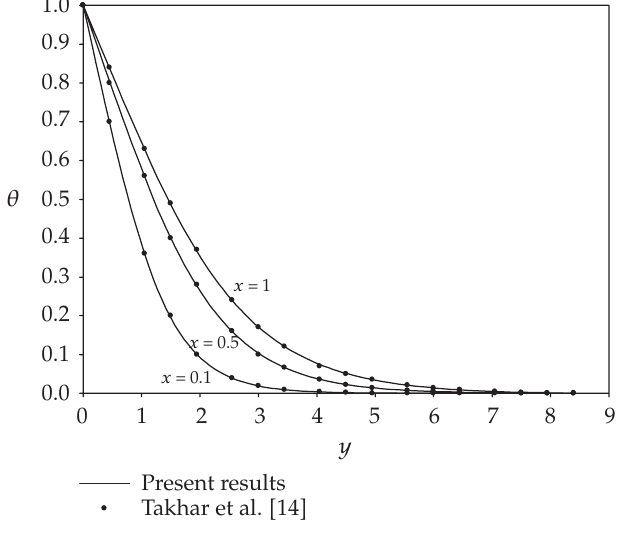
Figure 4.2 . Comparison of steady-state temperature profiles at dif- ferent values of x